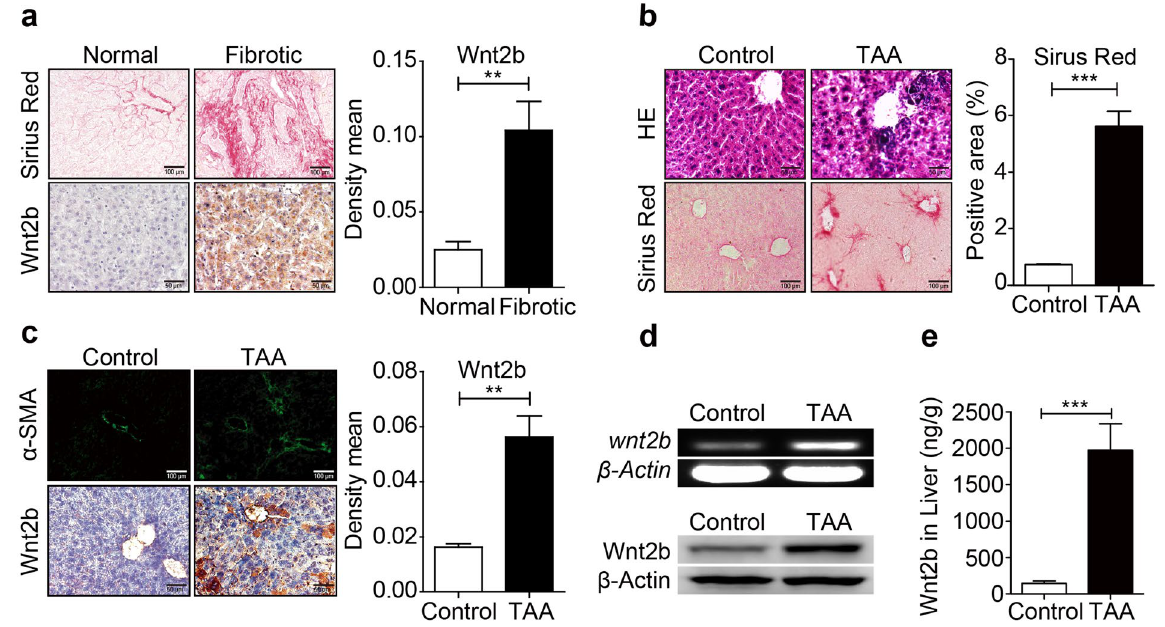
Figure 1. Wnt2b is elevated in hepatic fibrosis. ( a ) Representative Sirius Red staining, IHC staining of Wnt2b in liver tissue microarrays containing healthy controls (n = 9, with a mean age of 43.3 ± 1.4 years) and patients with fibrosis (n = 10, with a mean age of 48.8 ± 2.9 years). Hepatic fibrosis mouse model was induced by TAA, and then the following analyses were performed. ( b ) H&E, Sirius Red staining. ( c ) Immunofluorescence staining of α -SMA and IHC staining of Wnt2b. ( d ) RT-PCR (upper) and Western blotting (lower) of Wnt2b. Cropped blots are displayed; Full-length blots are presented in Supplementary Fig. S5. ( e ) ELISA analysis of Wnt2b in liver homogenate. Statistical analyses provided the mean ± SE (n = 8/group); * P < 0.05, ** P < 0.01, *** P <